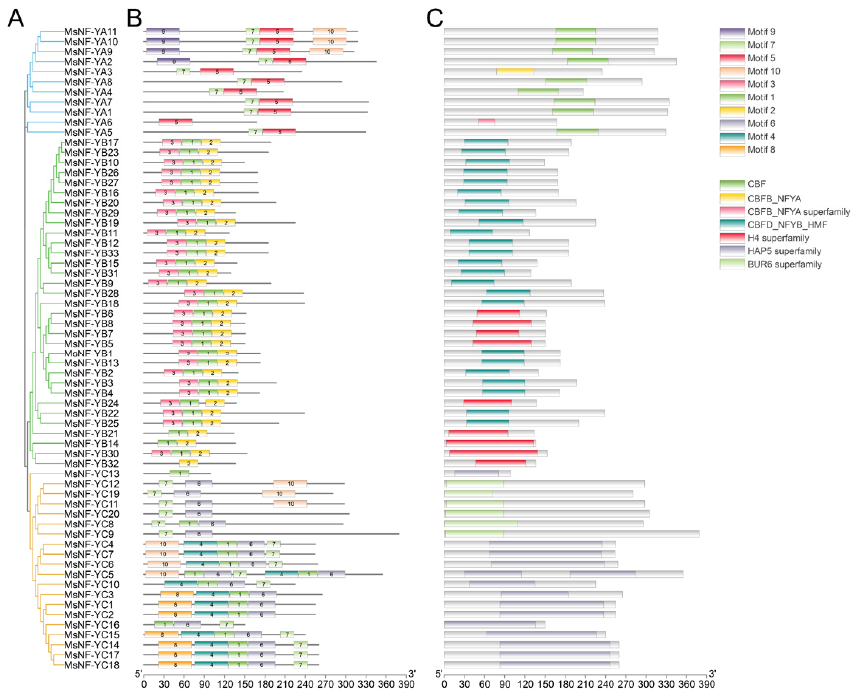
Figure 2. ( A ) Phylogenetic relationships, ( B ) conserved protein motifs and ( C ) conserved domains of MsNF-Y. The boxes with different colors represent the conserved motifs listed in Figure S2 and the conserved domains.